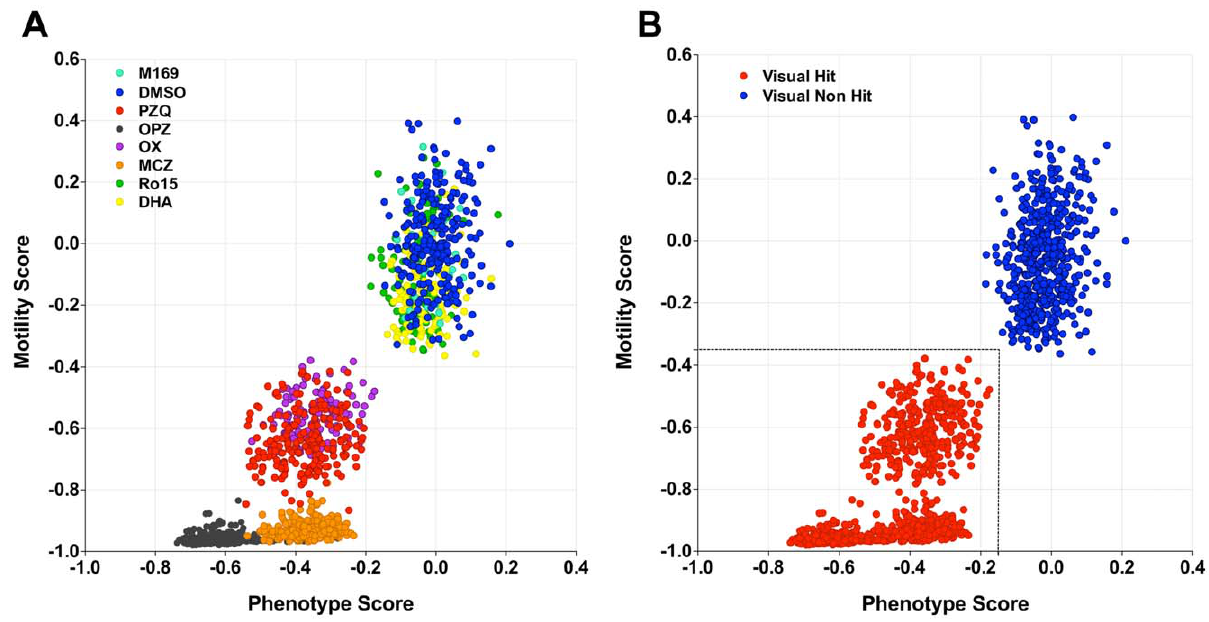
Figure 4. Combined phenotype and motility analysis compared with visual hit assessment for larvae treated with known anti- schistosome compounds. ( A ) Combined phenotype and motility scores for larvae treated with 10 m M praziquantel (PZQ; red), oltipraz (OPZ; black), methylclonazepam (MCZ; orange), Ro15-5458 (Ro15; blue), oxamniquine (OX; purple) dihydroartemisinin (DHA; yellow) and controls (M169; aqua & DMSO; green). ( B ) Visual assessment of hits (red) or non-hits (blue) for the wells shown in ( A ) with a visual hit defined as $ 70% damaged or dead schistosomula within a well [21]. Based on this, the dotted line shows the thresholds selected for definition of the hit region ( 2 0.15 for the phenotype score and 2 0.35 for the motility score). N=1500 wells across 5 plates containing anti-schistosome